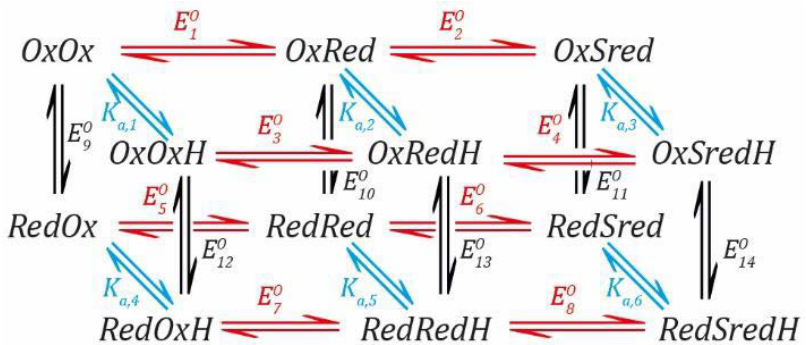
Scheme 7. Model for active [FeFe] hydrogenase including redox anti-cooperativity. The steps and redox potentials indicated in Red are the reduction of the H-cluster first from Ox to Red , then Red to Sred . The steps and K a values indicated in blue are protonation of the H-cluster in the Ox , Red, and Sred states. The steps and redox potentials indicated in black are the reduction of the proximal F-cluster from Ox to Red